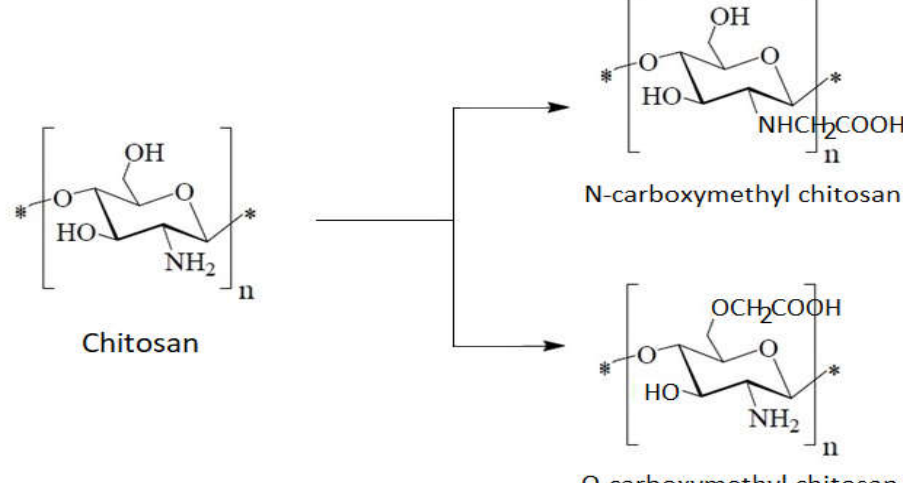
Figure 10. Schematic carboxyalkylation of chitosan.